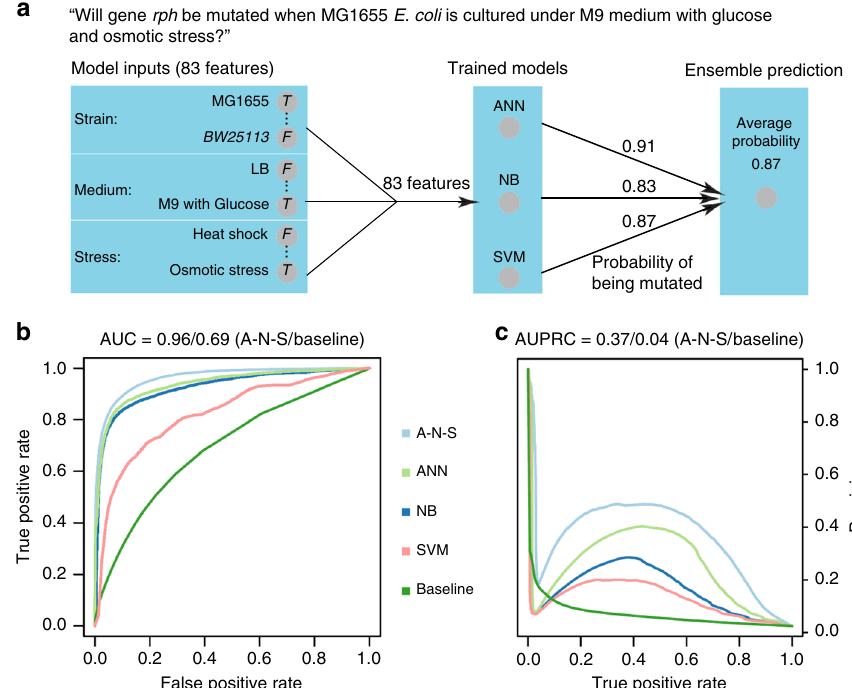
Fig. 5 Predictor performance. a Schematic depiction of the Ensemble predictor and an example of how the probability of a mutation is calculated given an input. The model input consists of 83 binary variables that capture experimental factors. The model output is a binary variable that captures the presence/ absence of mutation(s) in a speci fi c gene ( rph here), given a condition (MG1655, M9 with Glucose and Osmotic stress here). b The prediction performance of the ensemble predictor and each individual predictor in leave-one-condition-out-cross-validation. ROC curve. c Precision – recall curve. A-N-S is the Ensemble predictor. The baseline refers to the prediction based on the frequency of a mutation across different culture conditions in the